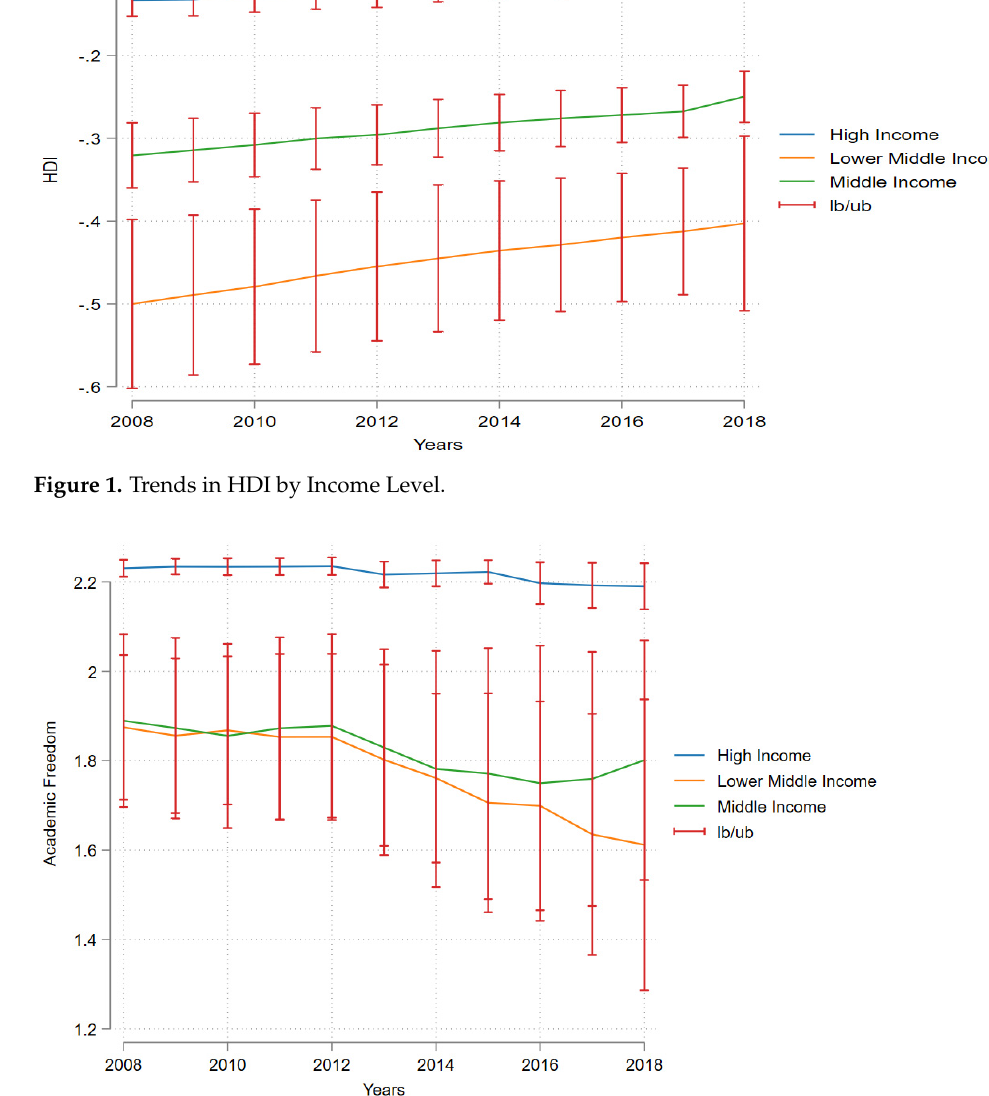
Figure 2. Trends in Academic Freedom by Income Level.